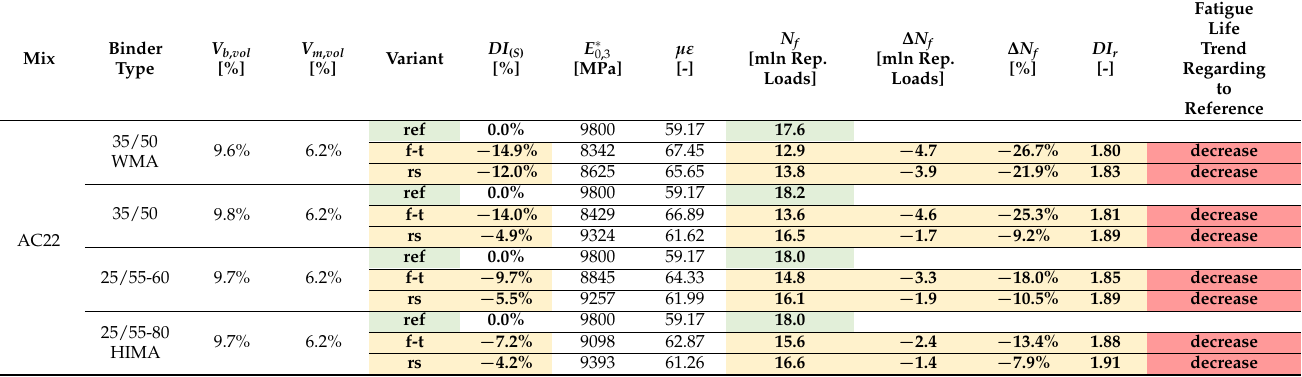
Table 6. Variability in pavement fatigue life due to water, frost, and road salt